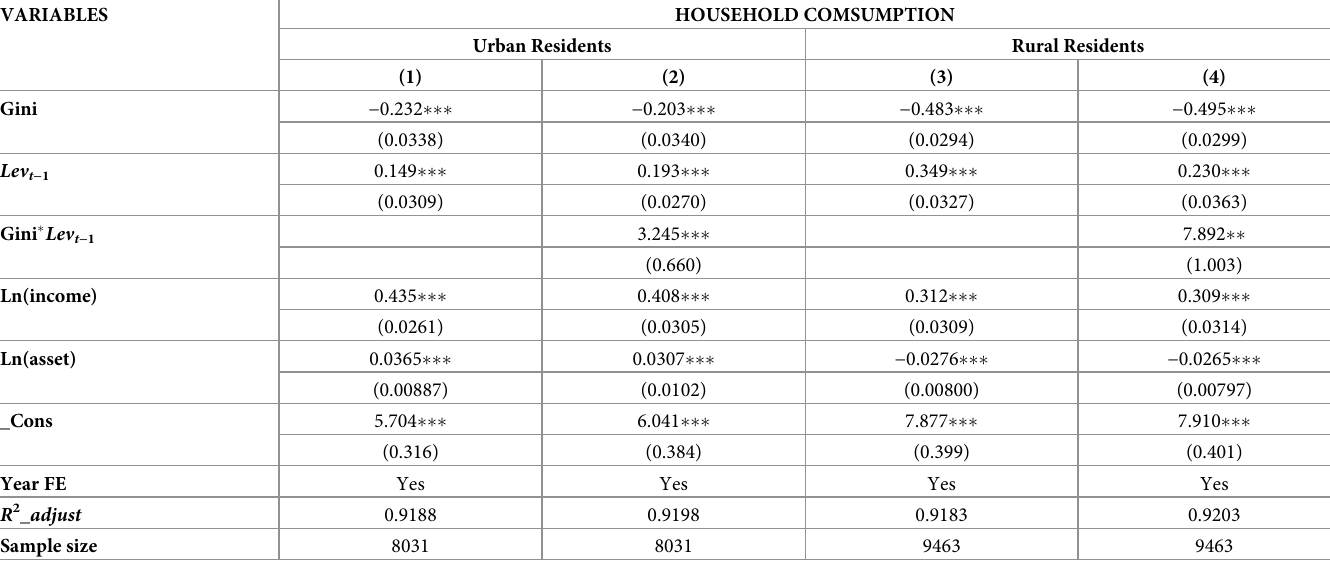
Table 5. Urban-rural differences in income inequality and household debt on household